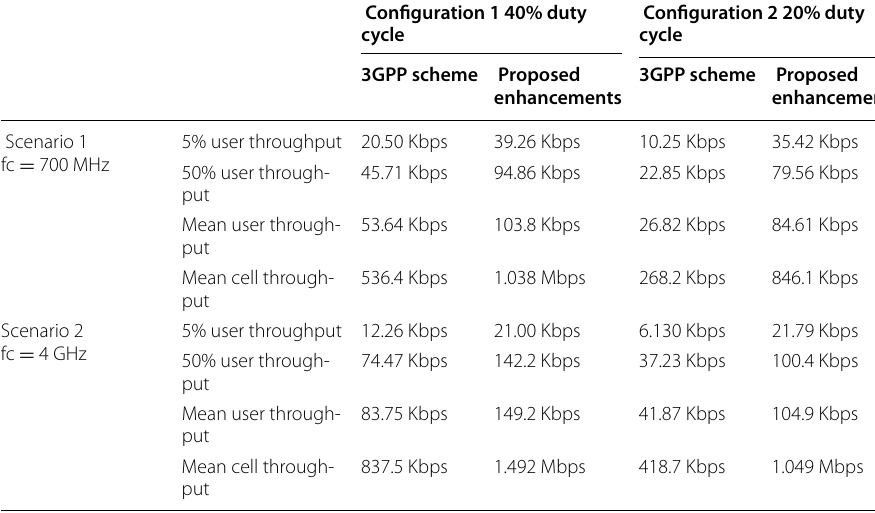
Table 9 Summary of throughput